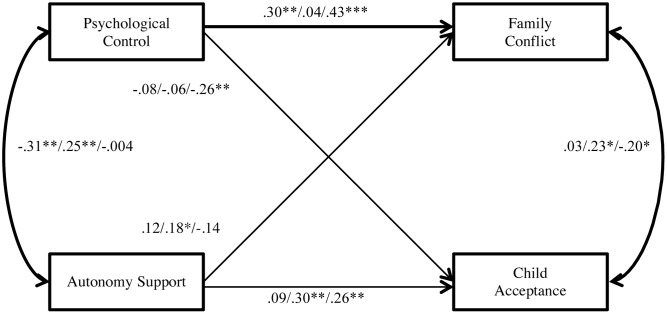
Multiple-group path analysis of parenting and family process variables. Standardized coefficients for each city is depicting following the format Beijing/Hong Kong/Los Angeles. Paths that are variant across groups are depicted in bold. Child sex, child age, mother age, and maternal education level were entered into the model as covariates. †p < 0.06, ∗p < 0.05, ∗∗p < 0.01, ∗∗∗p < 0.001.